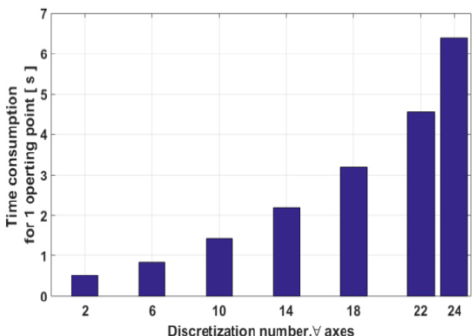
Figure 13. Consumption time for the hybrid model according to k (viz., the discretization number in massive conductive parts) for only one operating point.